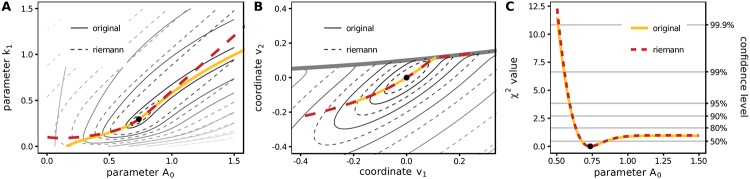
Landscape and profile of χ2.(A) The shape of the landscape is visualized by solid and dashed contour lines for the original and Riemann approximated χ2, respectively. The colored lines represent paths that are optimal with respect to the parameter k1 for any given value of parameter A0. (B) The non-quadratic χ2 turns into a quadratic function in Riemannian Normal Coordinates. The paths computed for (A) are shown in the new coordinates as colored lines. (C) The χ2 values along the exact and the approximated parameter paths agree well indicating that confidence intervals derived from either objective function coincide. Thresholds for different confidence levels are depicted in gray.